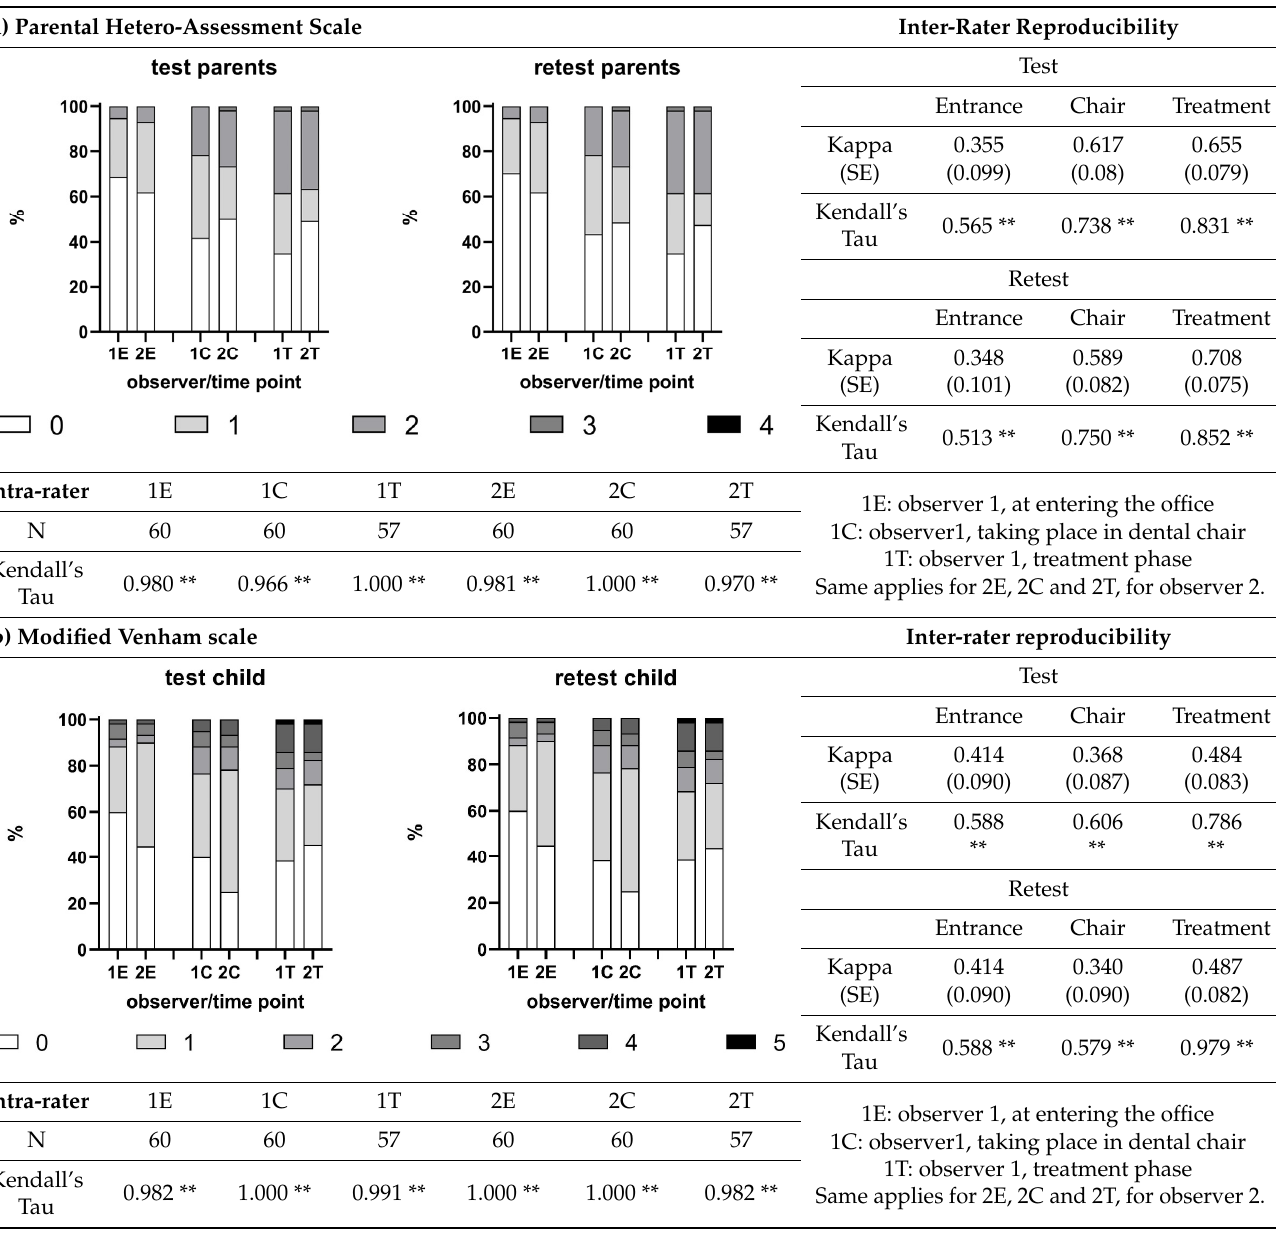
Table 4. Frequency tables for the parental hetero-assessment scale (a) and the modified Venham scale (b) for the two expert raters and the two scoring sessions (1,2 = Observer 1 or 2; E = Entering the office; C = Taking one’s place in the dental chair; T = Treatment phase). Inter-rater reliability was measured through Cohen’s Kappa and Kendall’s Tau rank-order correlations. The test–retest reliability was measured through Kendall’s Tau. ** Significant at level a = 0.001.